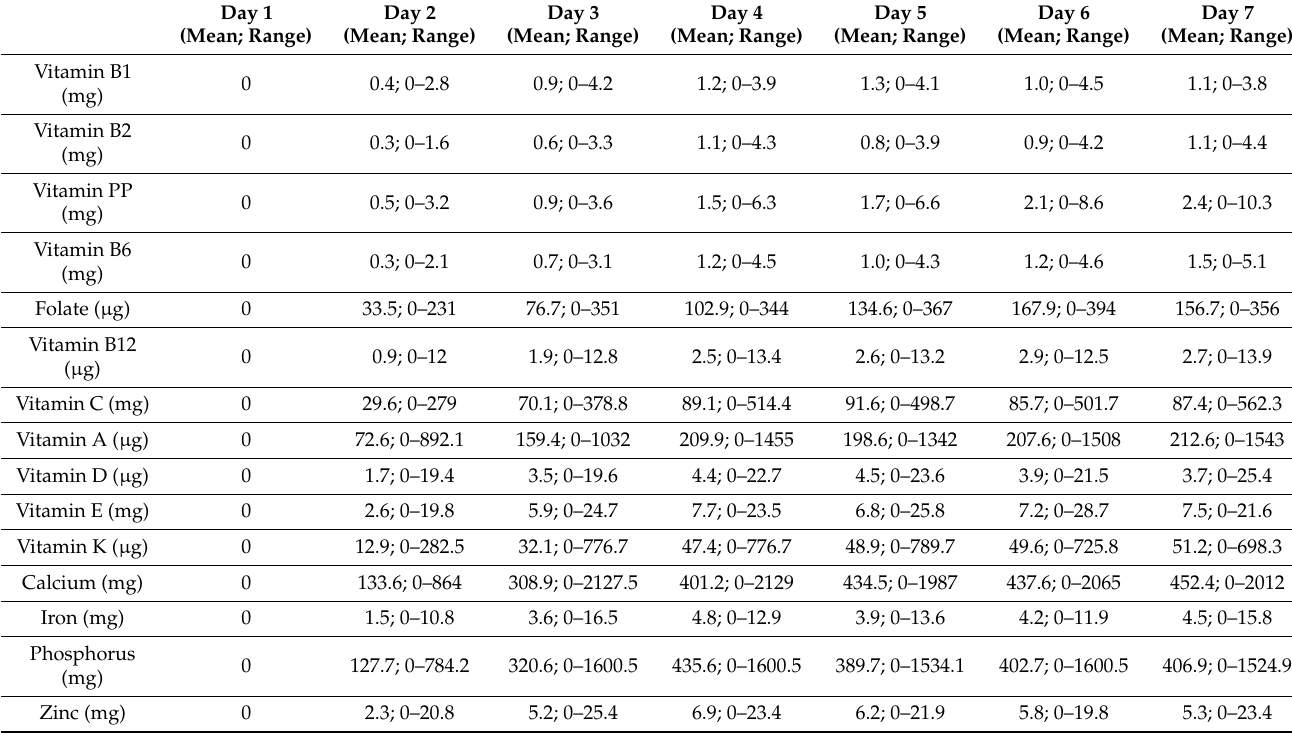
Table 8. Postoperative feeding regime for some vitamins and minerals of esophageal cancer